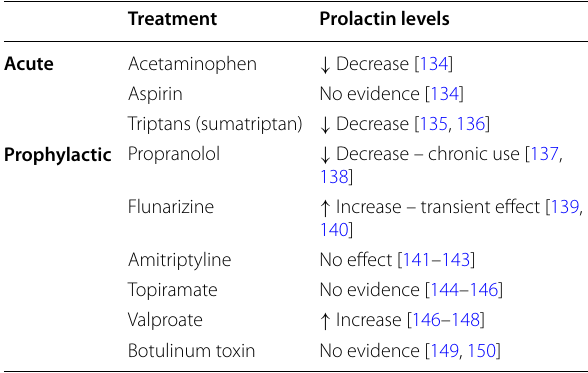
Table 1 Influence on prolactin levels of approved treatments for migraine (acute and prophylaxis)